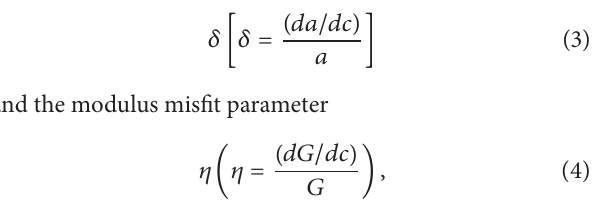
Mg-Li-(Al,Zn) alloys due to aging [3]. Xu et al. [19] found that the as-extruded LAM830-0.5Sr alloy exhibits an optimal elongation of 22.43%, which increases by approximately 43.97% compared with that of as-extruded LAM830